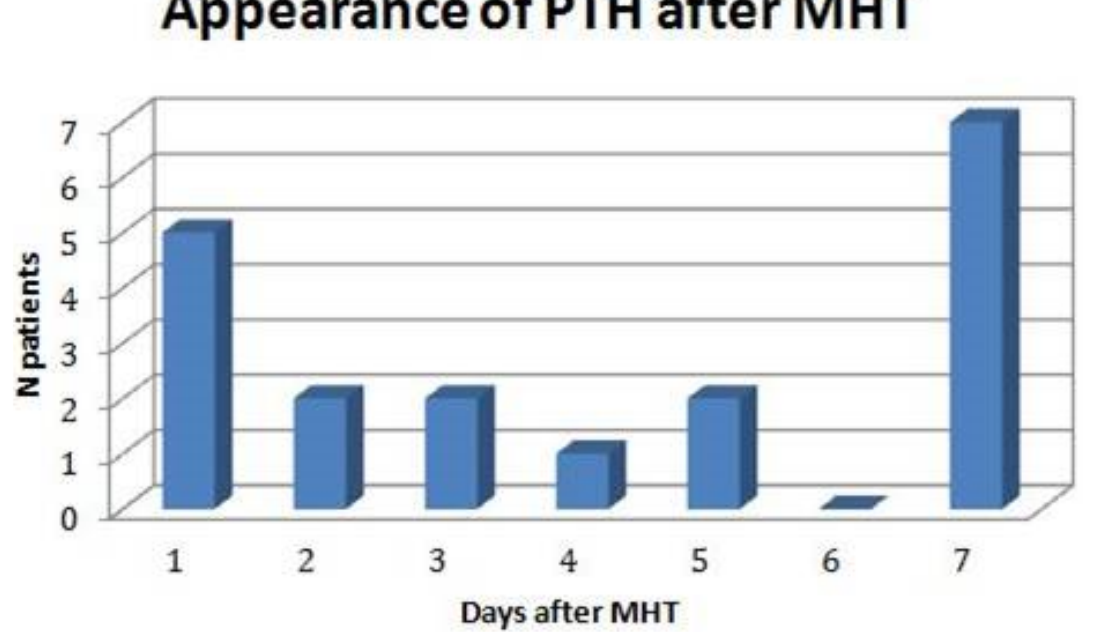
Figure 3. Day of appearance of post-traumatic headache (PTH) after minor head trauma (MHT) in 25 children aged 3–14 years.